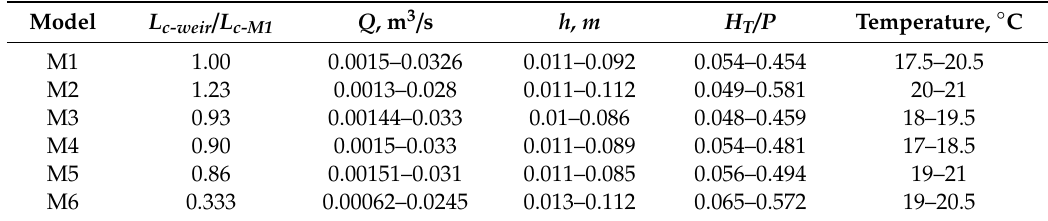
Table 2. Detail of the experimental